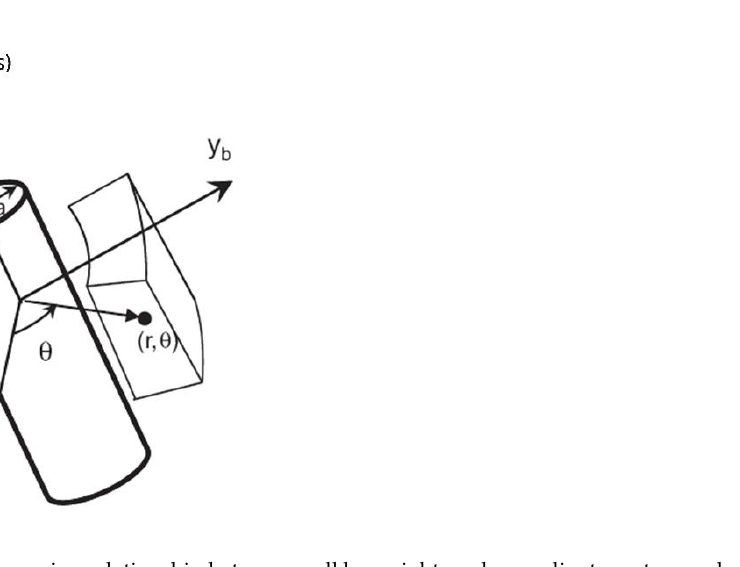
Figure 10. The risk of failure for fractures at different angles ( where, α represents the fracture direc- tion, β represents the fracture dip angle, the color value represents the slip risk of the fracture).